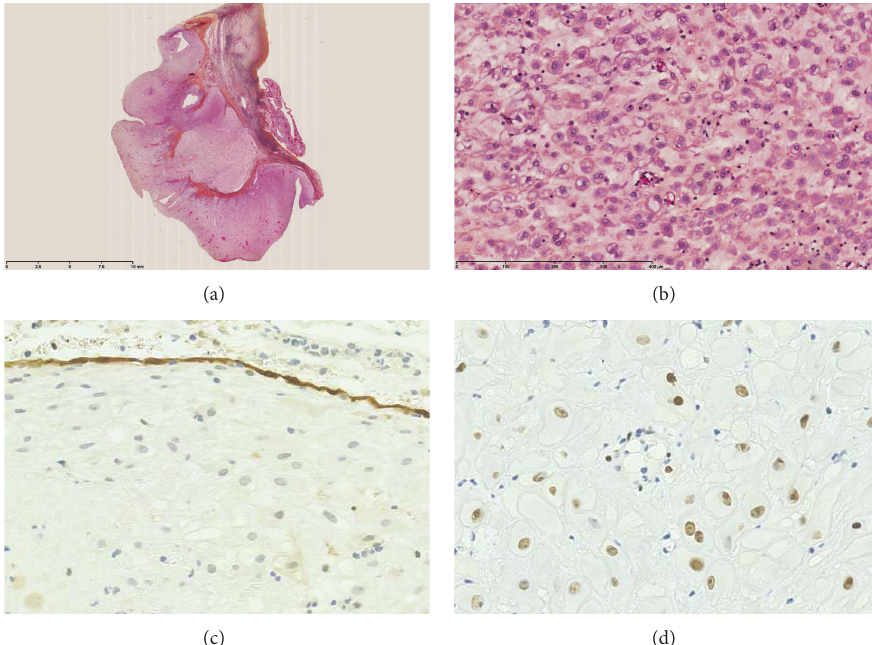
Figure 2: Microscopic examination of the left decidualized ovarian mass. Low magnification (a) shows an exophytic lesion developed on ovary surface (hematin eosin, × 0.5). High magnification (b) shows bland eosinophilic and granular epithelioid cells with no atypia nor mitotic activity (hematin eosin, × 20). By immunohistochemistry with calretinin (c) the epithelioid cells are negative (positive mesothelial cells are seen at the top), whereas they are stained by anti-progesterone receptor antibody (d) (brown nuclear